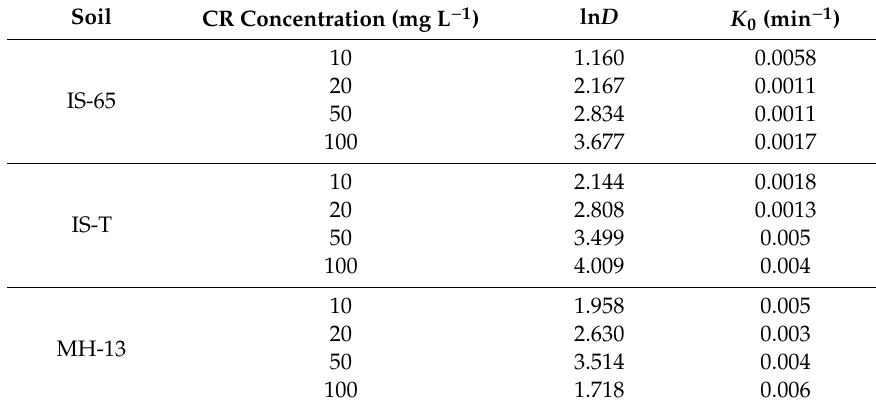
Table 8. Mass transfer coe ffi